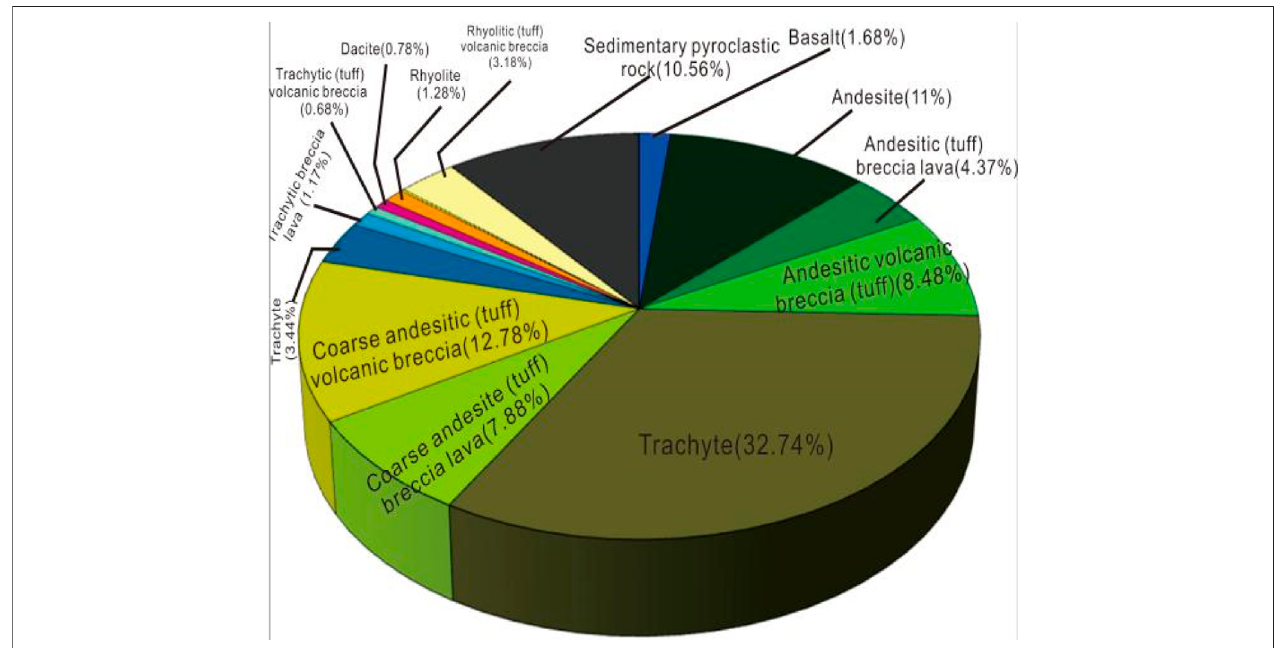
FIGURE 3 | Pie chart of volcanic rock lithology distribution in the Wangfu gas fi eld.